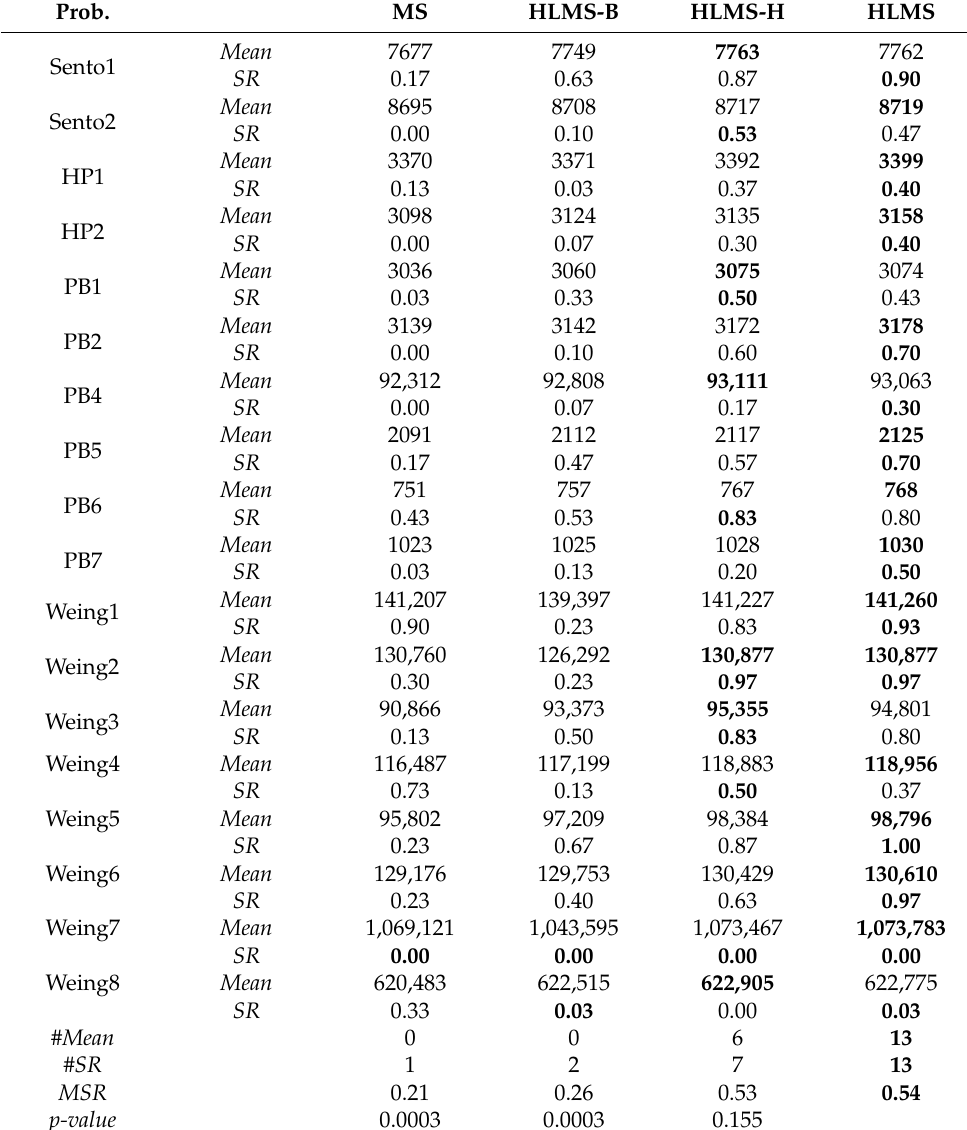
Figure 11. Boxplot for 5 parameter combinations on SR for Test set I. Table 8. Comparisons of MS, HLMS-B, HLMS-H, and HLMS on Test set I.